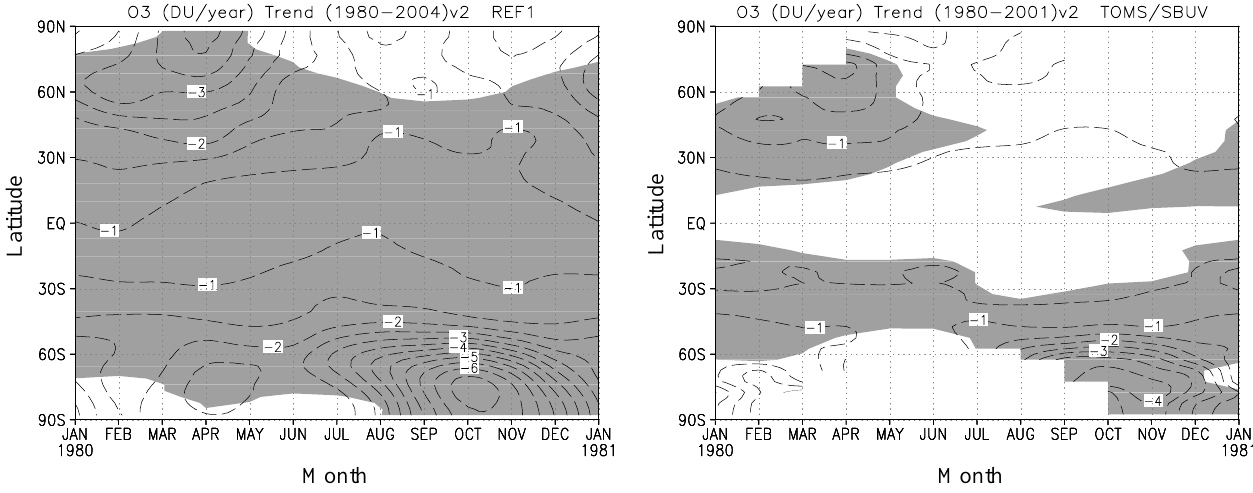
Fig. 11. Month-latitude cross sections of the total ozone trend (DU/year) between 90 ◦ S and 90 ◦ N for the simulation (left) and observation (TOMS/SBUV) (right). Contour interval is 0.5DU/year, and shading denotes the area of the trend different from zero at the 95% confidence level (t-test).